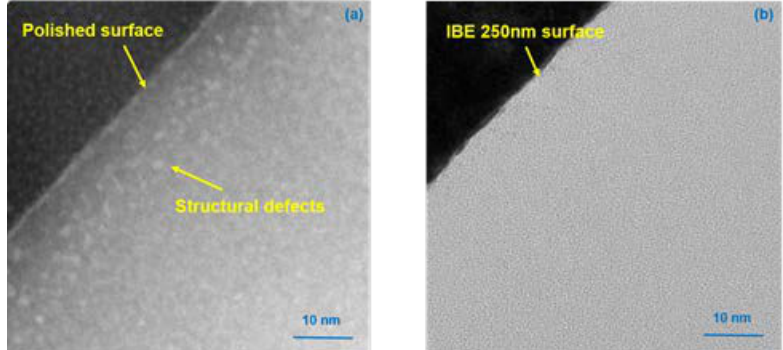
Figure 7. Subsurface layer in HRTEM: ( a ) Traditional polished surface (sample 0#): the structural defect layer formed during traditional polishing; ( b ) IBE 250 nm surface (sample 5#): a near-perfect subsurface is obtained with IBE.